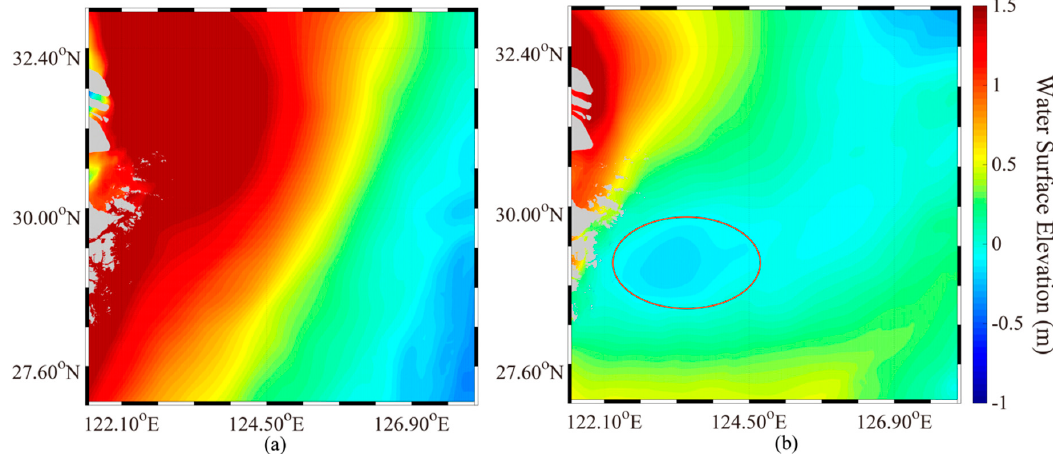
Figure 9. Sea-water-level maps from the FVCOM at ( a ) 13:00 UTC on 22 September 2014 and ( b ) 06:00 UTC on 11 July 2015.